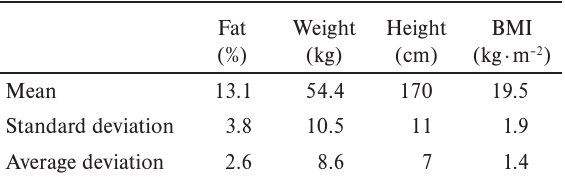
Basic anthropometric characteristics of participants